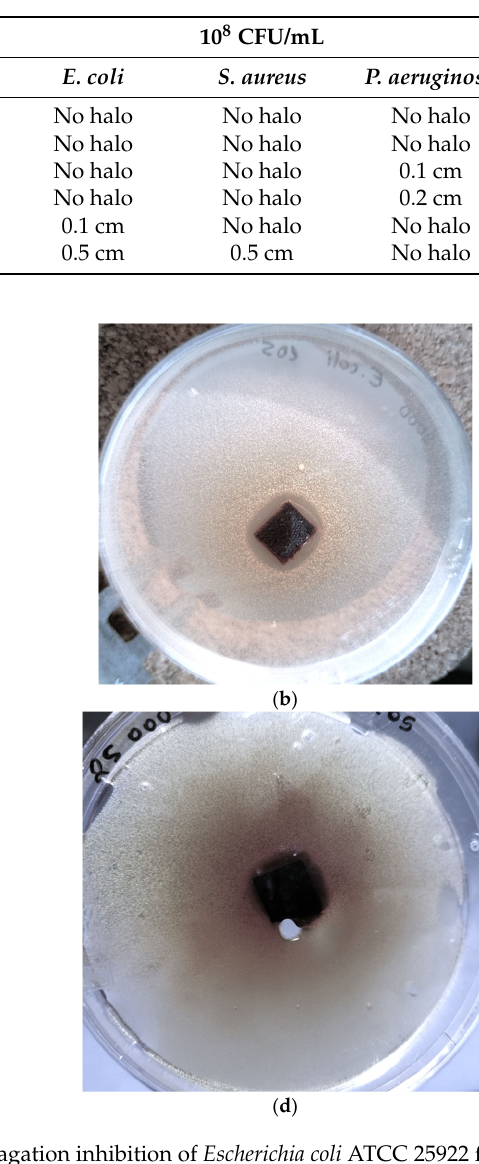
Figure 7. Representative examples of the propagation inhibition of Escherichia coli ATCC 25922 from: ( a ) leather coated by silica PEI 25,000 ‐ ampicillin xerogel, ( b ) leather coated by silica PEI 2000 Ag Nps xerogel of Staphylococcus aureus ATCC 29213, ( c ) leather wetted by PEI 25,000 Ag Nps solution, and ( d ) silica PEI 25,000 Ag Nps xerogel.